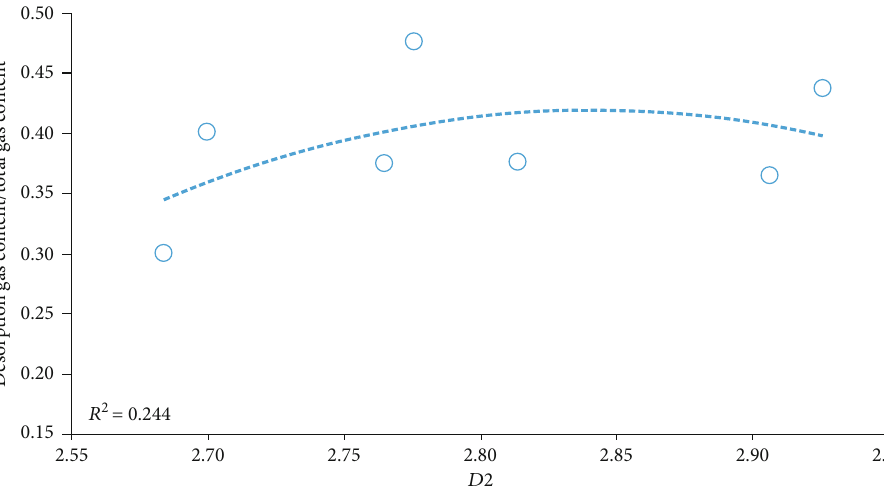
Figure 11: Correlation between gas-bearing composition and fractal dimensions of Longtan